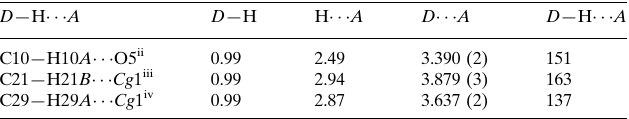
Hydrogen-bond geometry (A˚ , (cid:3)